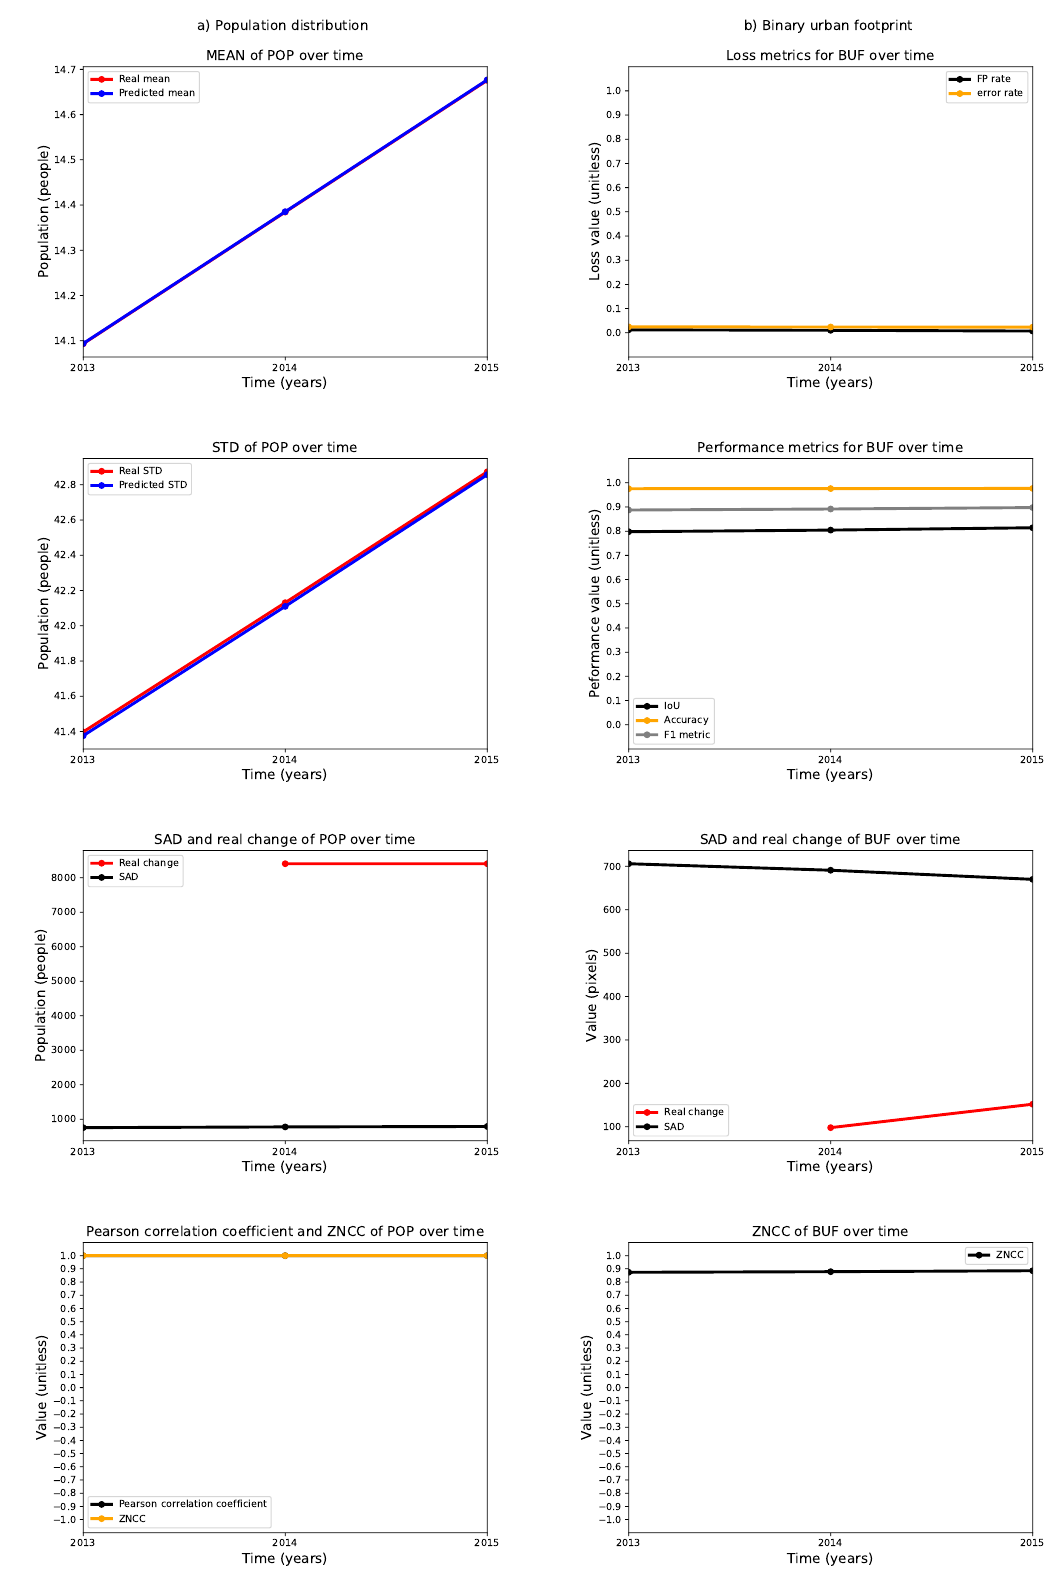
Figure 24. Assessment of the urban predictions in the geographic area of interest masked by the administrative division of Valledupar with the test